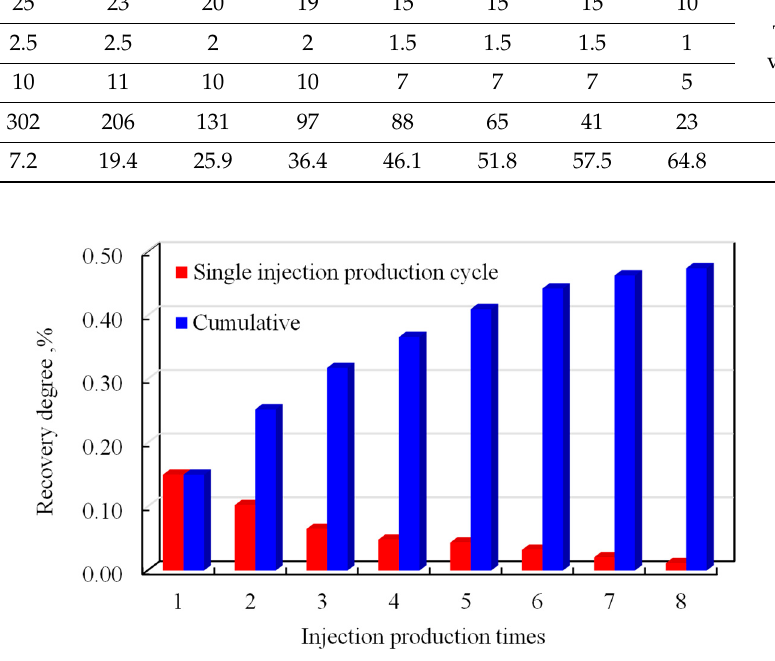
Figure 4. Extraction degrees under different injection cycles.